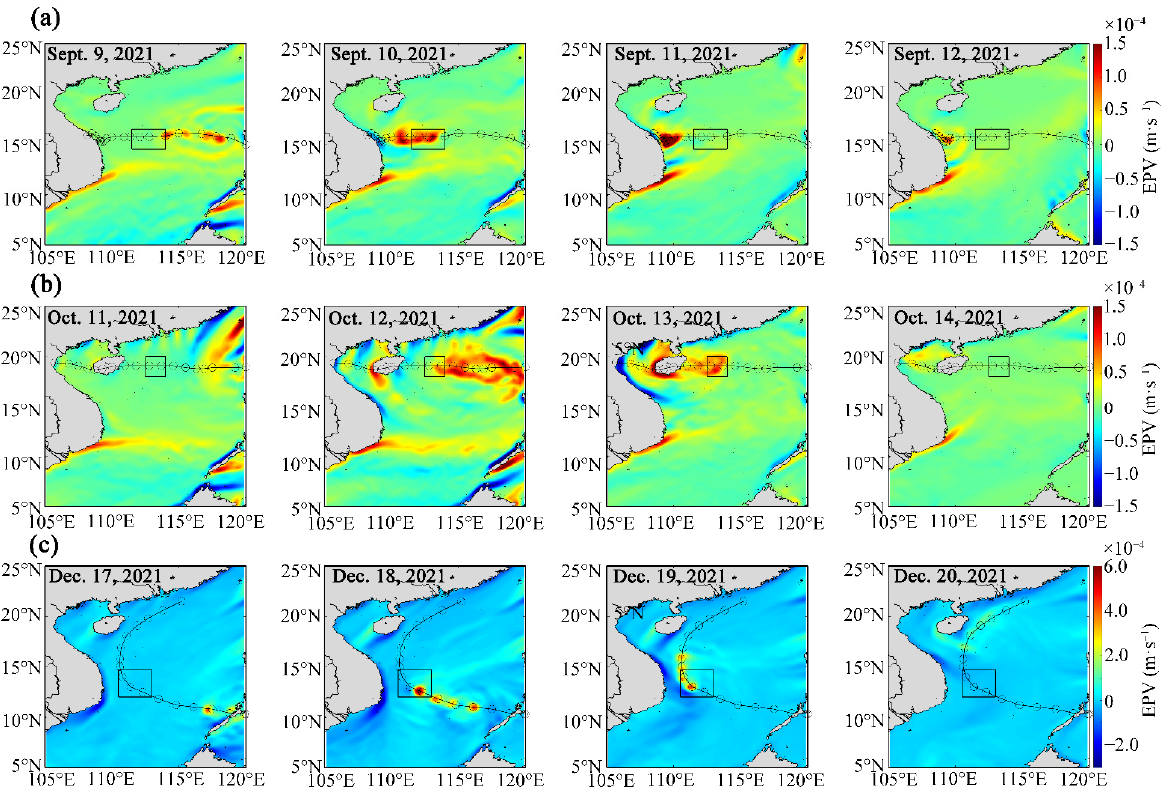
Figure 11. The EPV before and after the passage of ( a ) STS “Conson”, ( b ) TY “Kompasu” and ( c ) STY “Rai”. Before the passing of STS (9–10 September 2021), after the passing of STS (11–12 September 2021). Before the passing of TY (11–12 October 2021), after the passing of TY (13–14 October 2021). Before the passing of STY (17–18 December 2021), after the passing of STY (19–20 December 2021). The black circle represented the location of the tropical cyclones every 6 h. The black line represented the path of the tropical cyclones. The color bar range of STS and TY is − 1.5~1.5 × 10 − 4 m · s − 1 and STY is − 3.0~6.0 × 10 − 4 m · s − 1